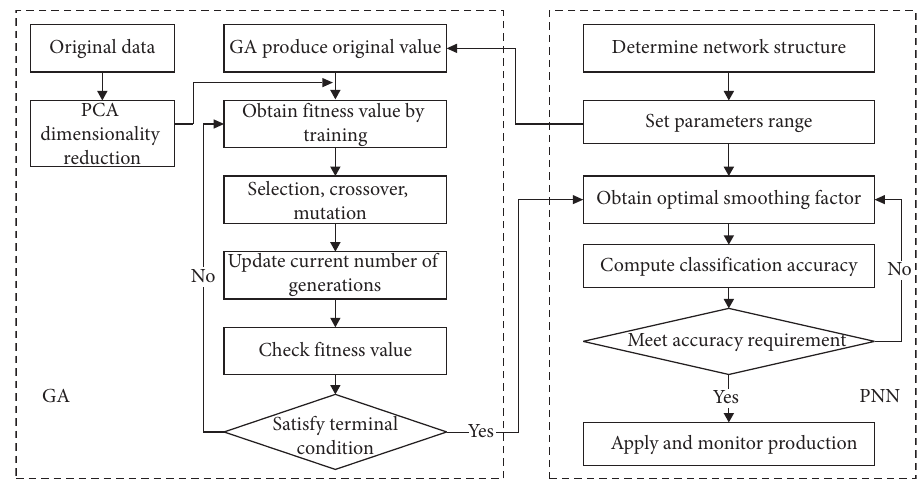
Figure 2: Quality anomaly recognition model.